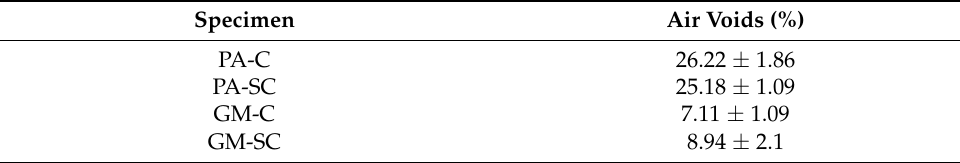
Table 5. Air-void content for porous and grouted macadam asphalt samples.